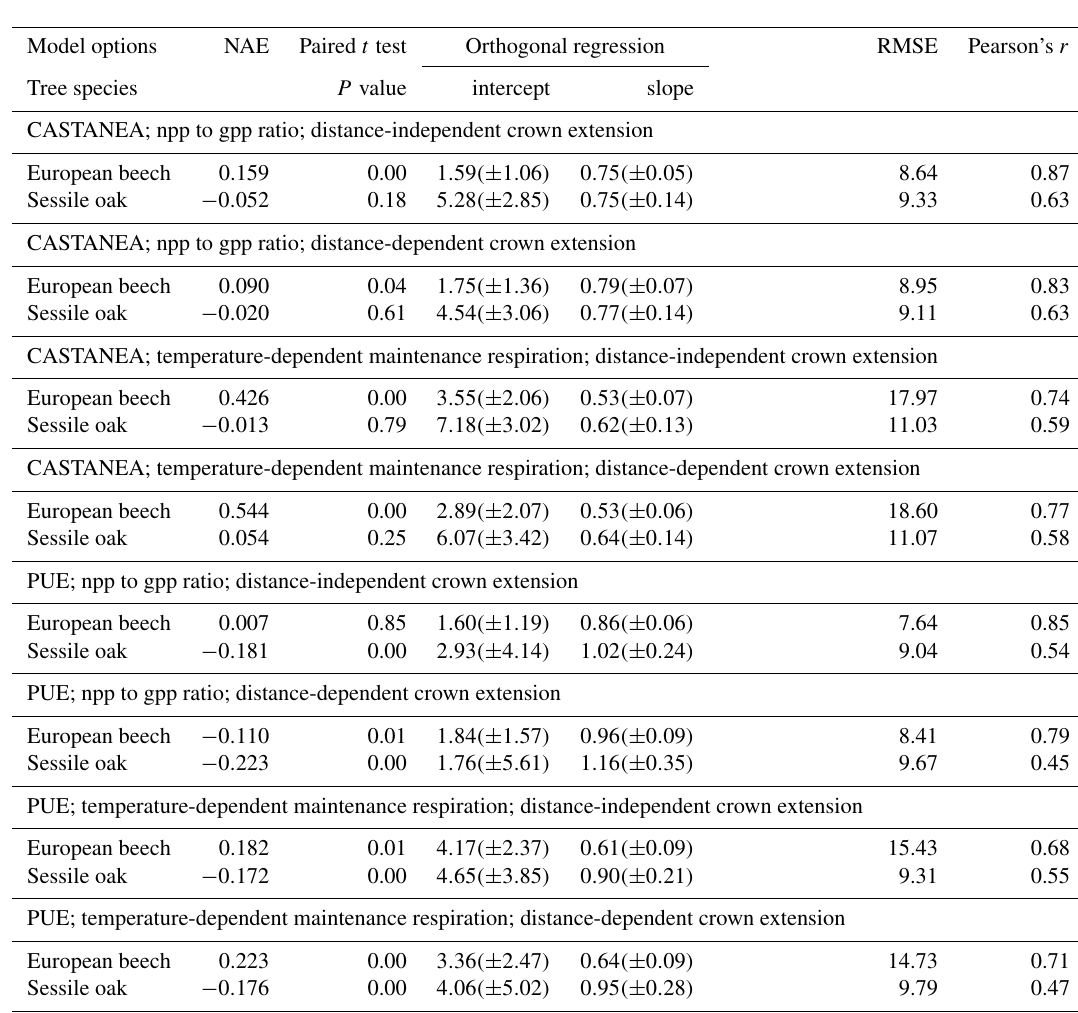
Table 3. Statistical evaluation of predicted basal area increments (vs. observations) for various combinations of model options using nor- malized average error (NAE), paired t test, regression test, root mean square error (RMSE) or Pearson’s correlation (Pearson’s r ). Standard deviation or confidence intervals are provided in